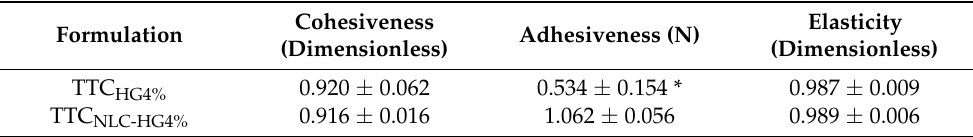
Table 2. Mechanical properties of TTC HG4% and TTC NLC-HG4% , at 32 ◦ C, determined by texture profile analysis. The values are shown as mean ± standard